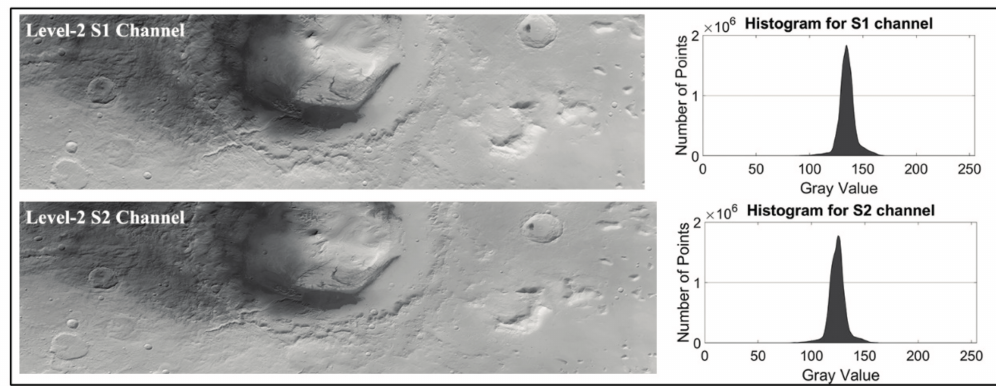
Figure 1. The illustration of the terrain characteristics of the Martian surface using the HRSC Level-2 images of orbit 5273. The default pixel data type of the High Resolution Stereo Camera (HRSC) Level-2 images is 16-bit integer, whereas the histograms only plot the valid values between 0 and